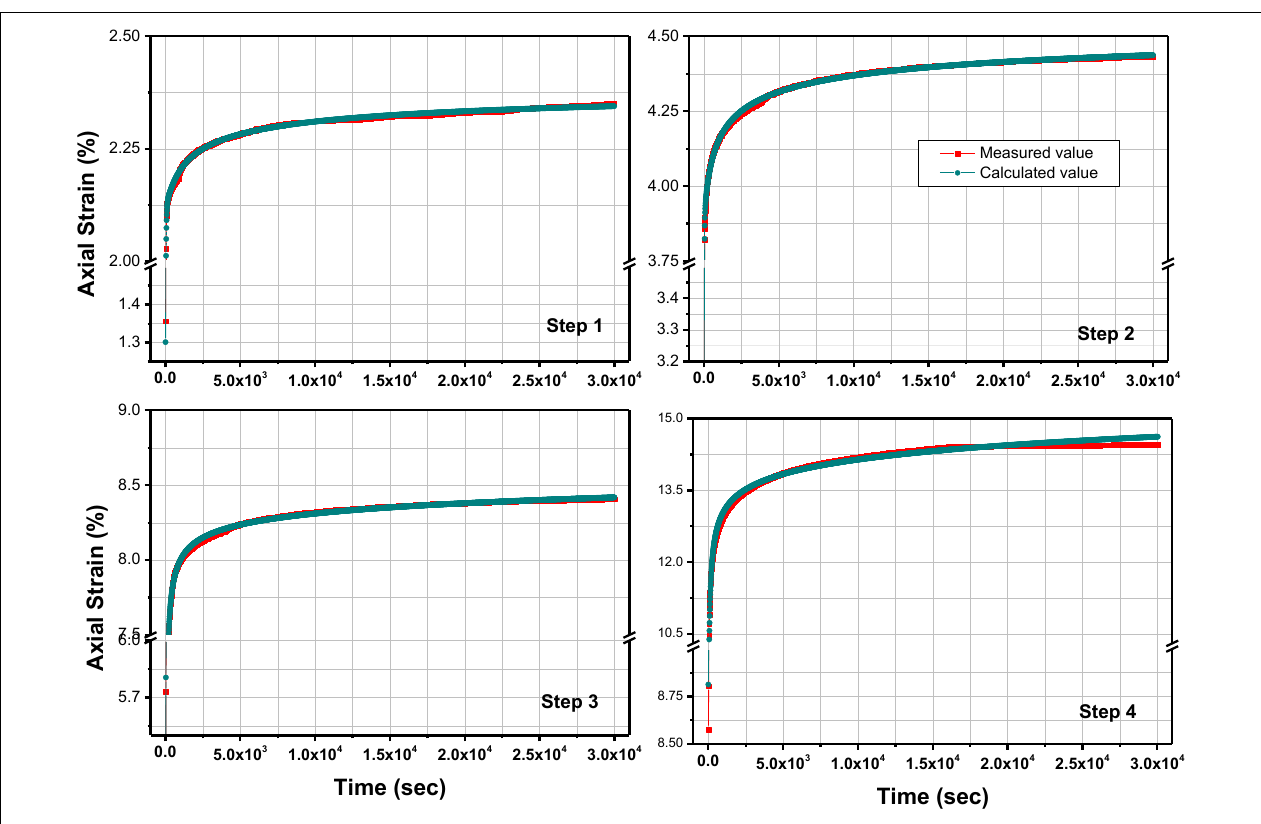
FIGURE 13 | Fitted curve obtained from the Empirical Creep Model compared to the strains obtained from the test data.